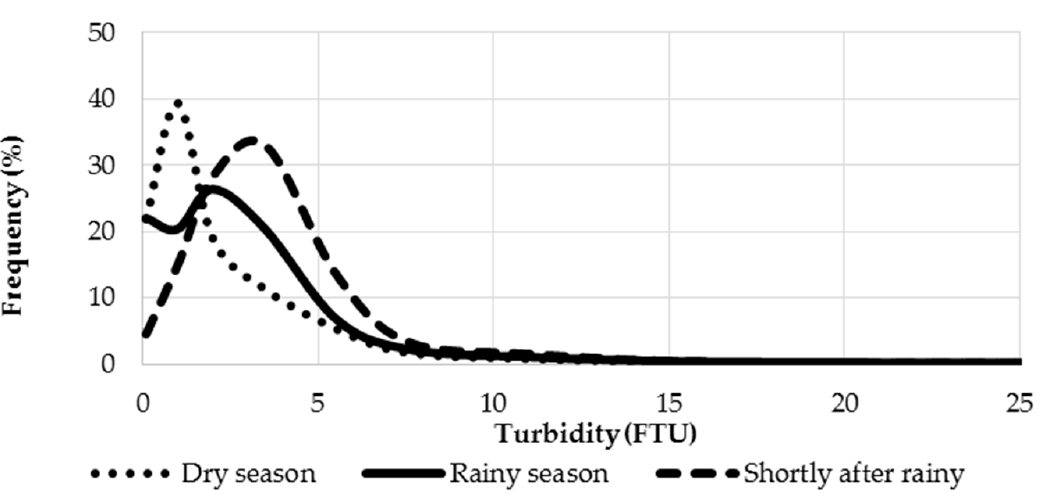
Figure 5. Frequency distribution of mean turbidity retrieved from Landsat 8 OLI images from 2013 to 2016 using the empirical model of Equation (9) in rainy season (four scenes), dry season (six scenes), and shortly after rainfall in dry season (eight scenes).